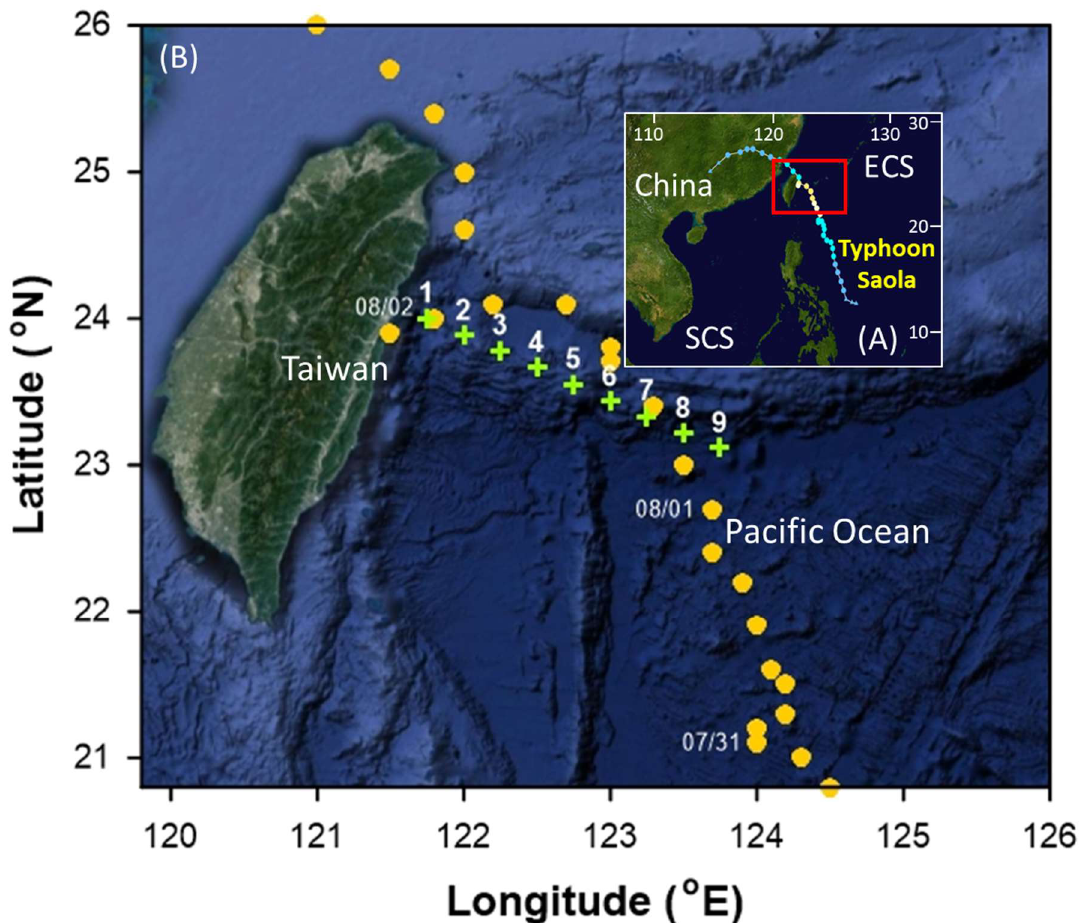
Figure 1. Locations of sampling sites off eastern Taiwan and the inserted map showing the full path of typhoon Saola in the northwest Pacific Ocean. of typhoon Saola in the northwest Pacific